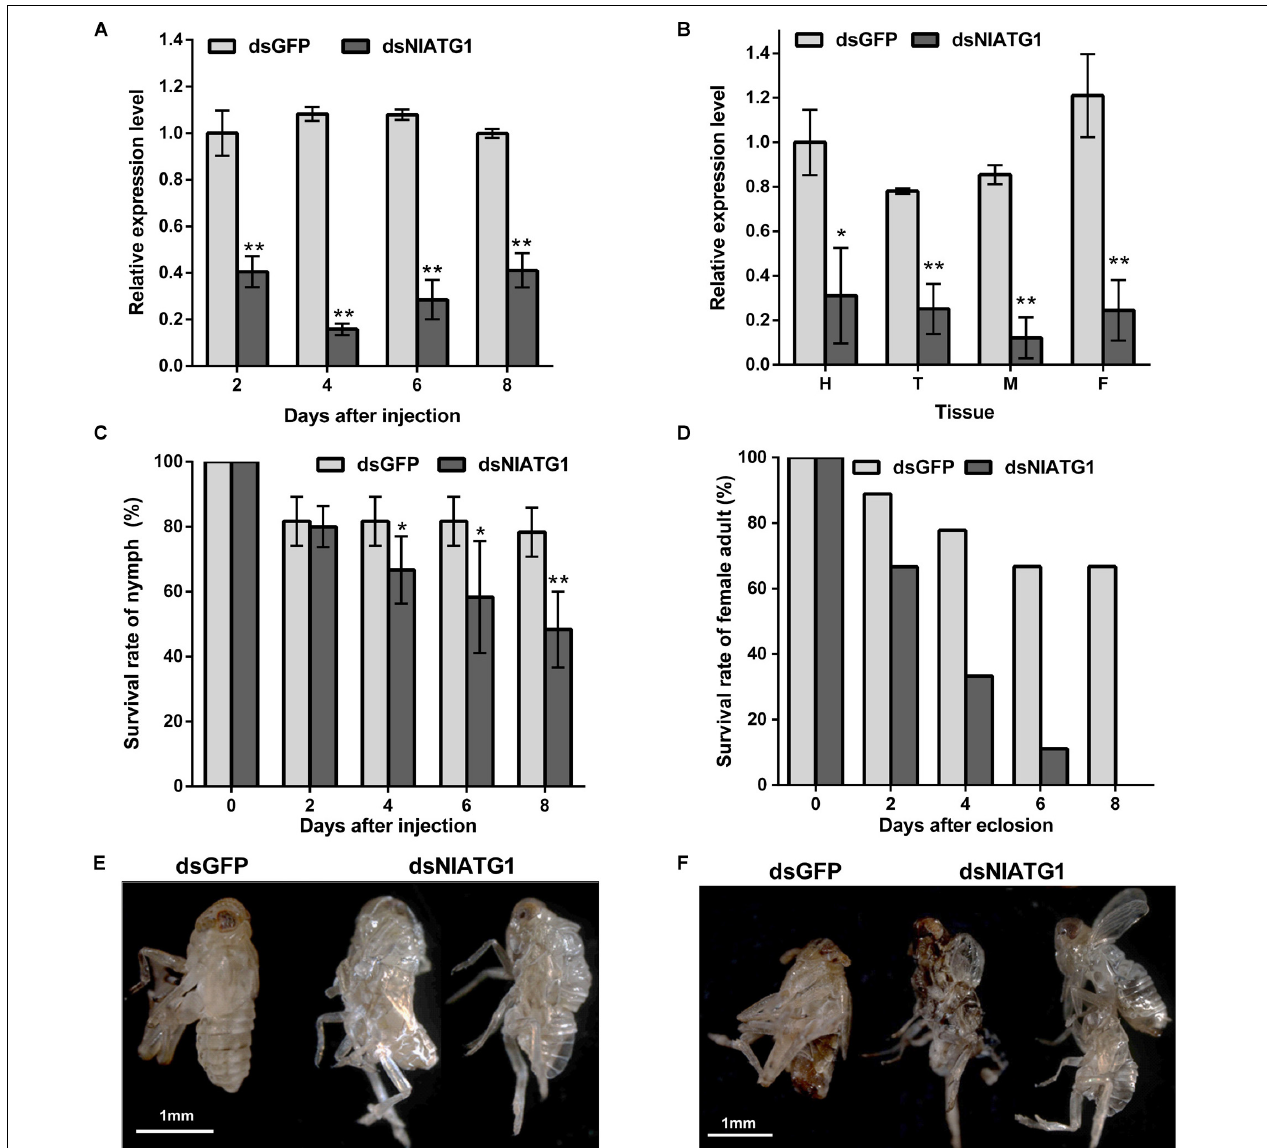
FIGURE 3 | Effects of NlATG1 gene RNA interference on BPH. (A,B) Effect on the mRNA expression level of NlATG1 microinjected with dsRNA at different treatment times (A) and in different tissues at day 4 (B) . The reference was the mRNA level of BPH treated with dsGFP at day 2 (A) and head (B) . (C,D) Effect of NlATG1 RNAi on the survival rate of BPH nymph (C) and female adult (D) . All values are presented as the means ± SD of three independent replicates (* p < 0.05, ** p < 0.01). (E,F) Some BPH died of failure in molting and eclosion; scale bars: 1